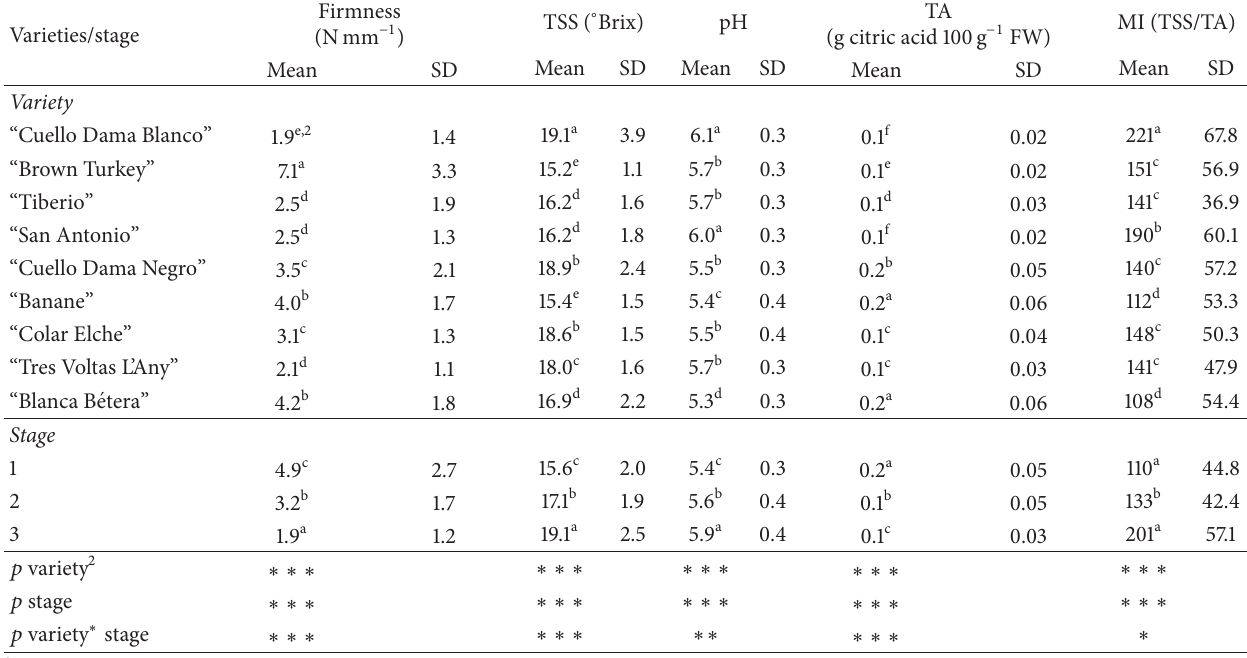
Table 1: Values of firmness, TSS, pH, TA, and MI for the breba varieties and commercial ripening stages studied.